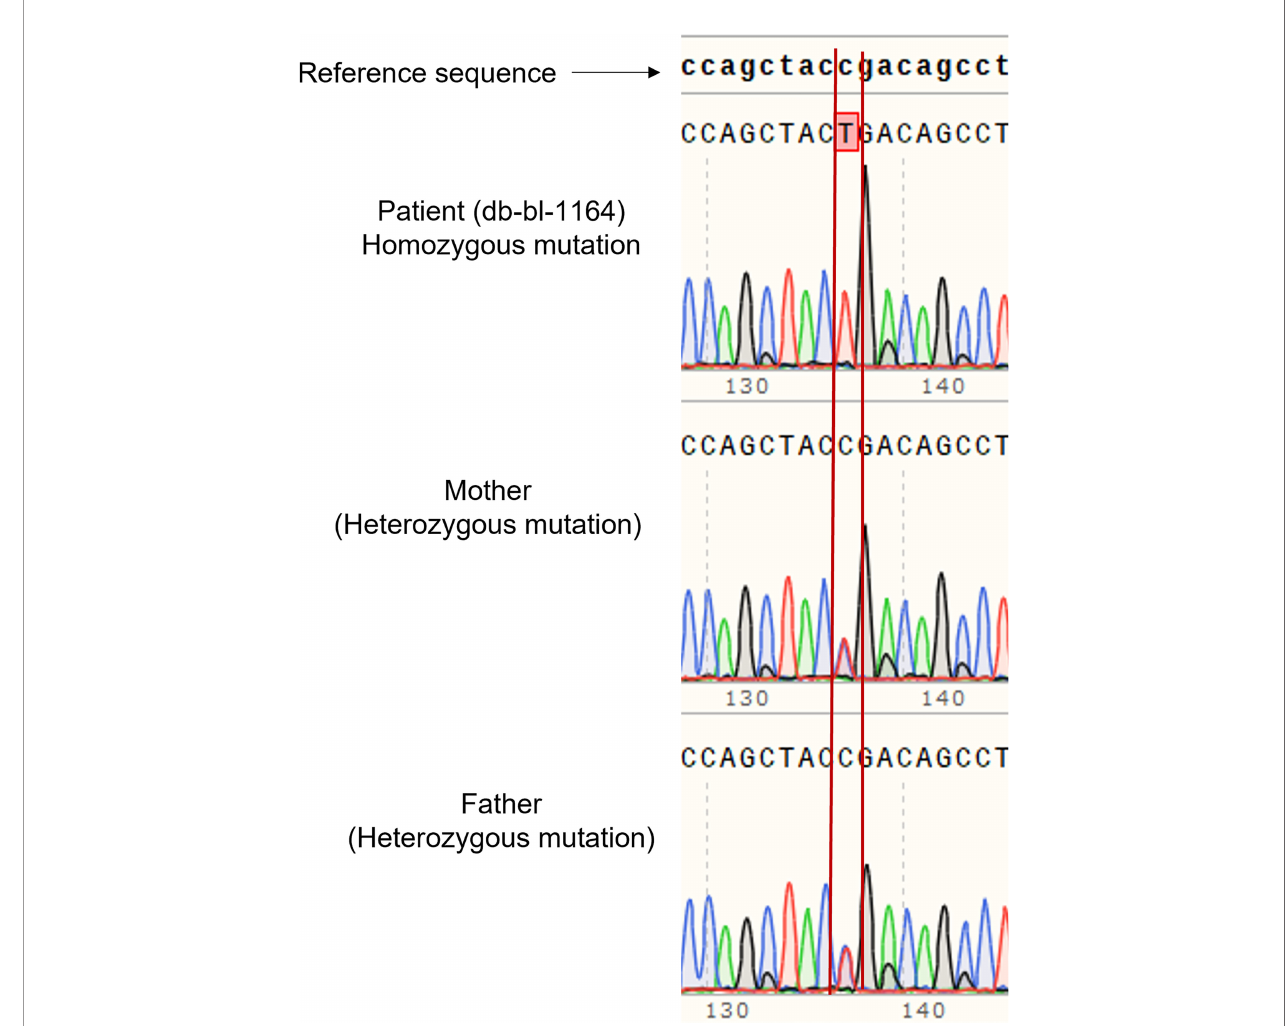
FIGURE 2 | Genetic analysis of patient and parents. Sanger sequencing of DNA of the patient showed homozygous mutation of SLC2A2 (c.901C>T, R301X), and the parents are carriers.